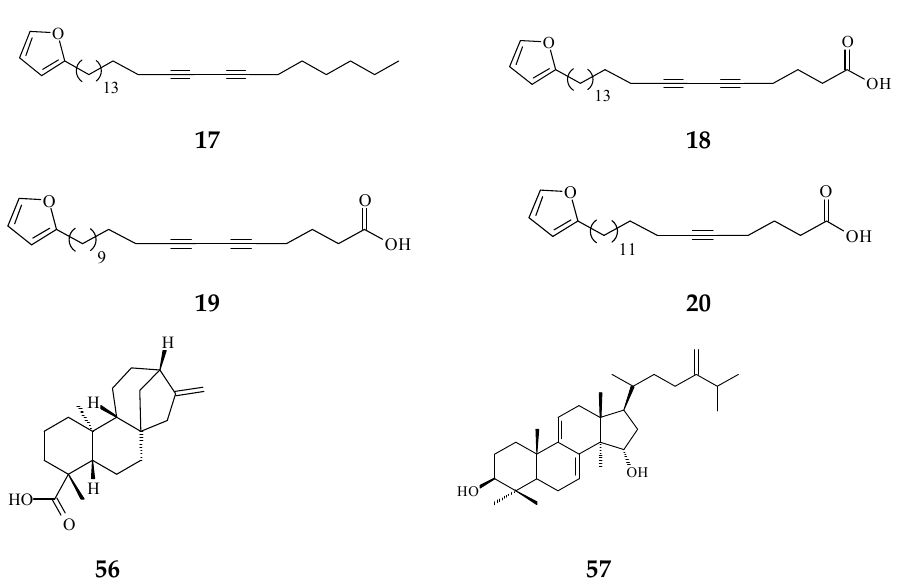
Figure 8. The phytochemical compounds isolated from species of Polyalthia exhibit anti-viral activity (17–20, 56, and 57).